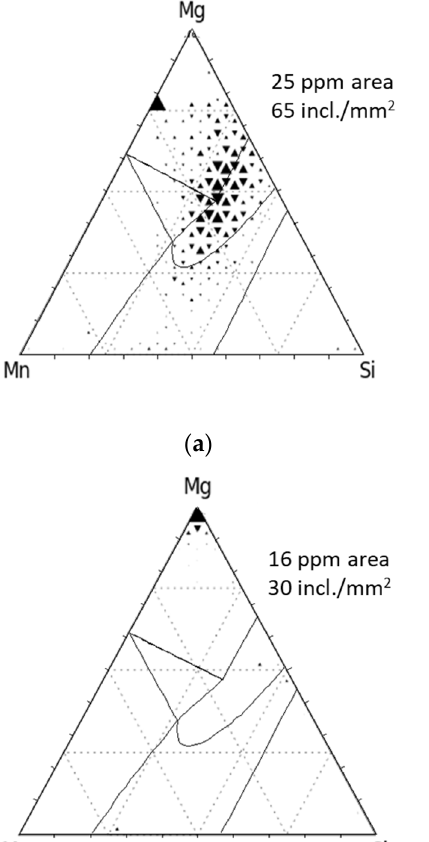
Processes 2021 , 9 , x FOR PEER REVIEW 7 of 11